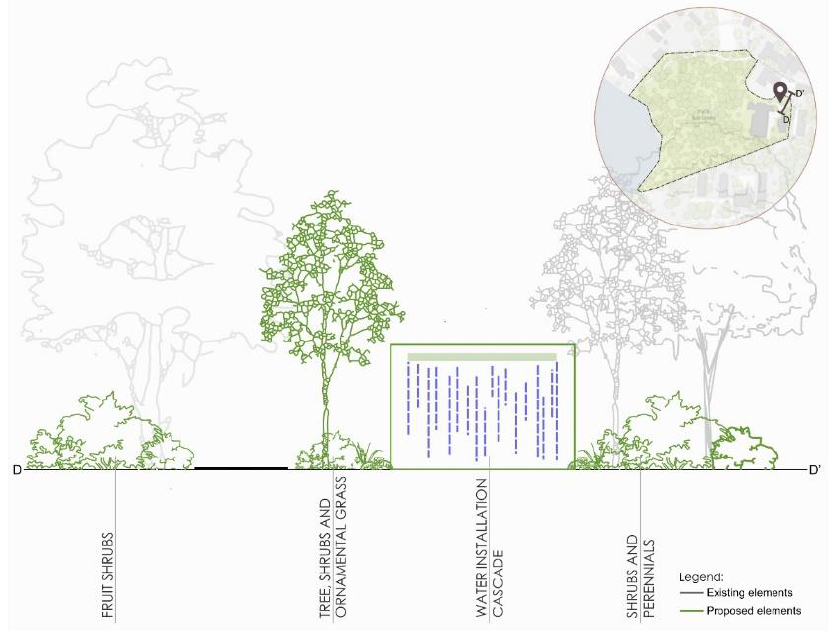
Figure 12. Scheme for re-design of the D zone in Kortowo